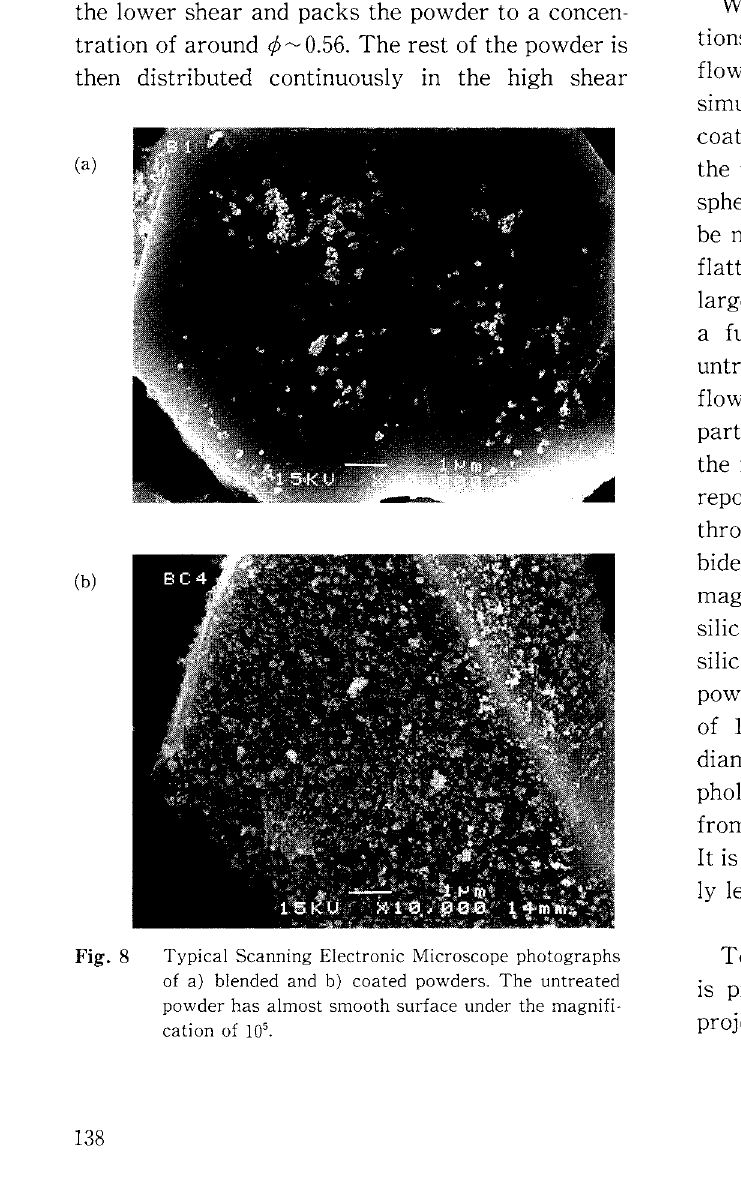
Typical Scanning Electronic Microscope photographs of a) blended and b) coated powders. The